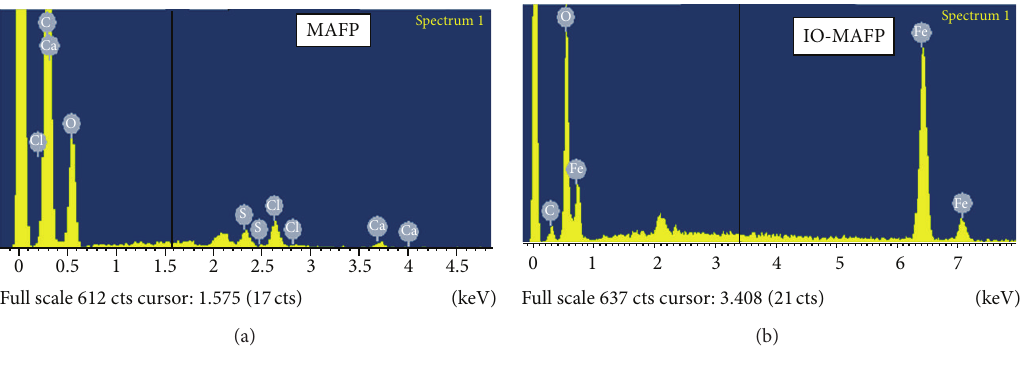
Figure 3: SEM-EDX spectrum of MAFP biomass and